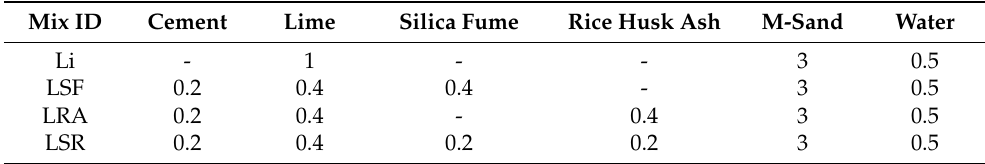
Table 3. Ratio proportion of materials